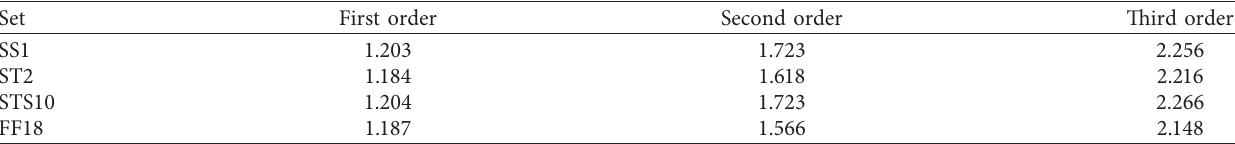
Table 3: First three orders of natural frequency under different conditions (unit: